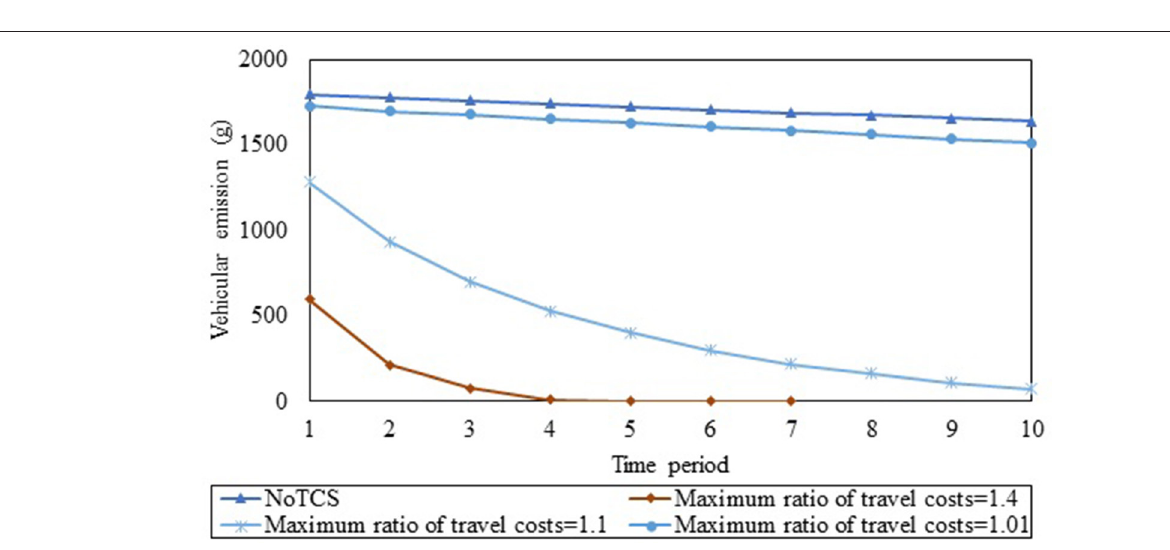
Frontiers in Built Environment |